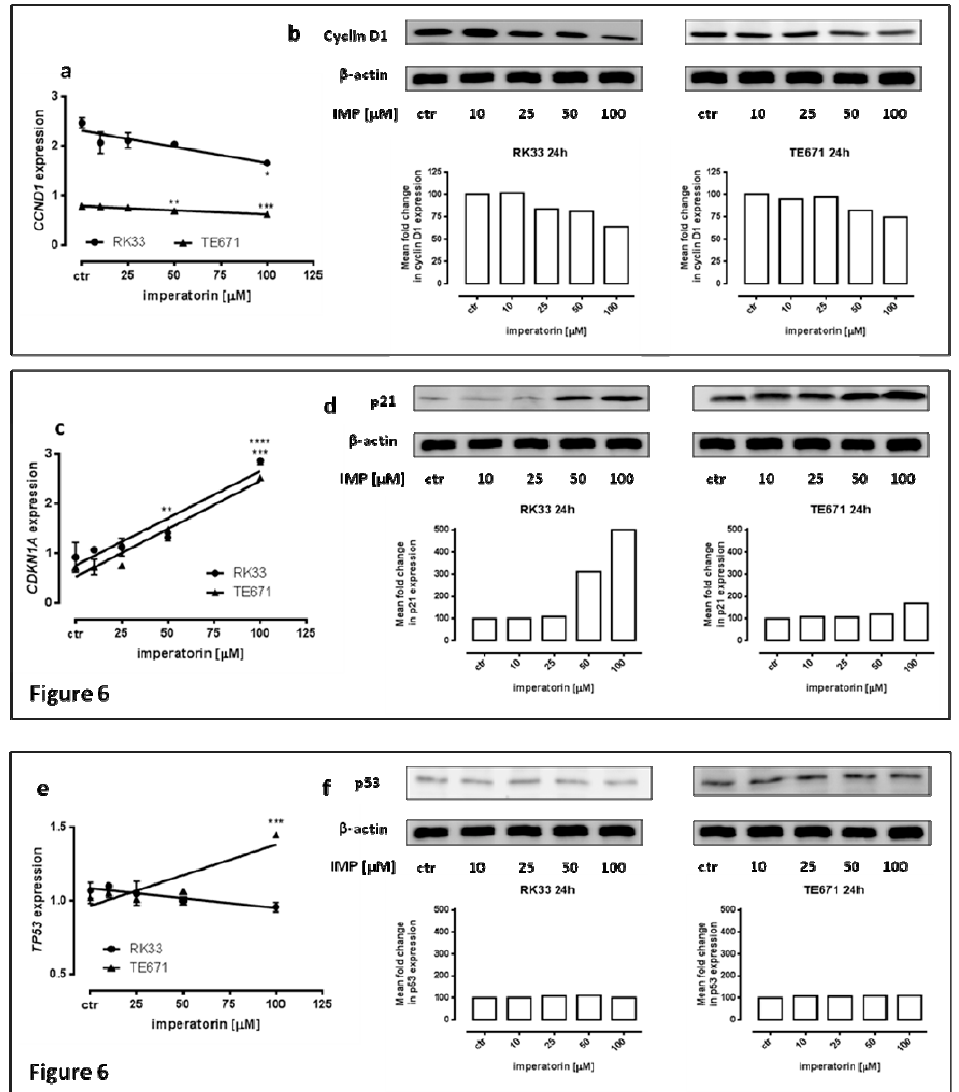
Figure 6. p21, cyclin D1, and p53 expression on protein and mRNA level in human rhabdomyosarcoma and larynx cancer cell lines. Quantification of CCND1 ( a ) and CDKN1A ( c ) and TP53 ( e ) genes expression by means of qPCR in RK33 and TE671 cells exposed (24 h) to imperatorin (25–100 µM) compared with controls (* p < 0.05; ** p < 0.01; *** p < 0.001; **** p < 0.0001; n = 9 measurements from three separate experiments, Tukey’s test). Western blots were normalized to β -actin and densitometric analysis of the bands was performed by ImageJ program ( b , d , f ).